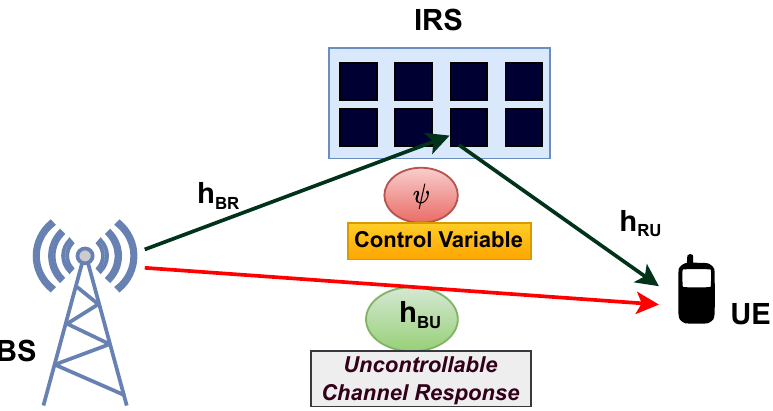
Figure 8. IRS-assisted Communication System: Single IRS and Single